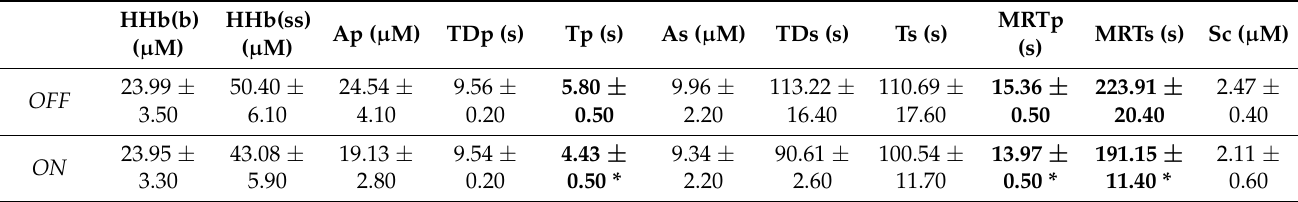
Values are mean ± SD. HHb(b), deoxyhemoglobin at baseline level; HHb(ss), deoxyhemoglobin at steady-state level; Ap, amplitude of response for primary component; TDp, time delay for primary component; τ p, time constant for primary component; As, amplitude of p <